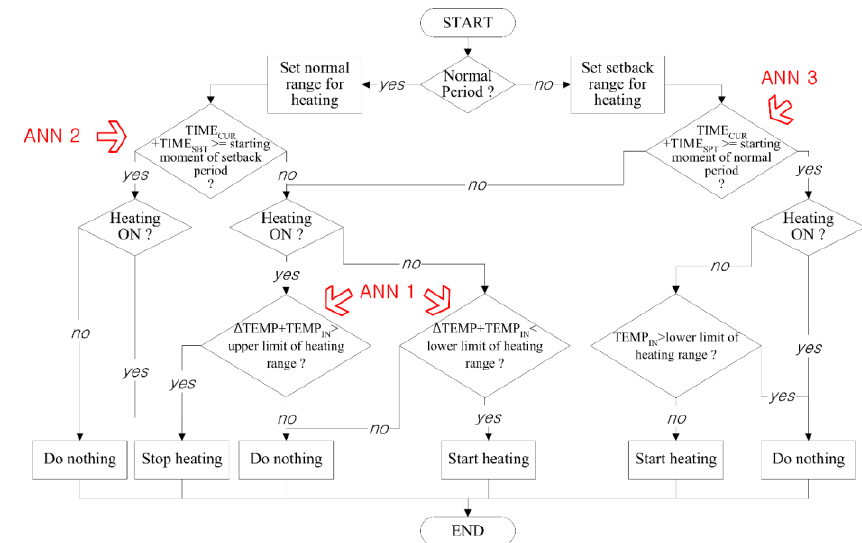
Figure 5. The control algorithm.